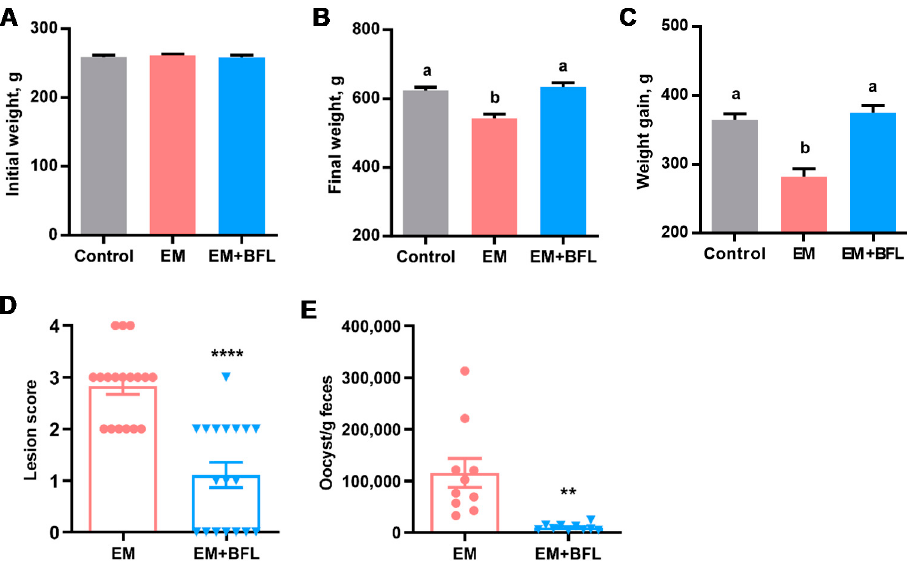
Figure 5. Attenuation of coccidiosis in broiler chickens by supplementation of butyrate, forskolin, and lactose. Day-of-hatch male Cobb chicks were supplemented with or without 1 g/kg microen- capsulated sodium butyrate, 10 mg/kg forskolin-containing C. forskohlii extract, and 10 g/kg lactose (BFL) ( n = 18) upon arrival. Animals in the EM or EM + BFL group were orally challenged with 2 × 10 4 sporulated E. maxima (EM) on day 11 after overnight fasting, while the control group were mock-infected. Chickens were weighed individually on day 11 ( A ) and day 18 ( B ), and weight gain between days 11–18 ( C ) was calculated. Weight and weight gain were analyzed with one-way ANOVA and post hoc Tukey’s test. Means with different letters are significantly different ( p < 0.05). Jejunal lesions ( D ) and fecal oocyst shedding ( E ) were examined on day 18 and subjected to unpaired Student’s t -test. Results are presented as means ± SEM. ** p < 0.01, and **** p < 0.0001.